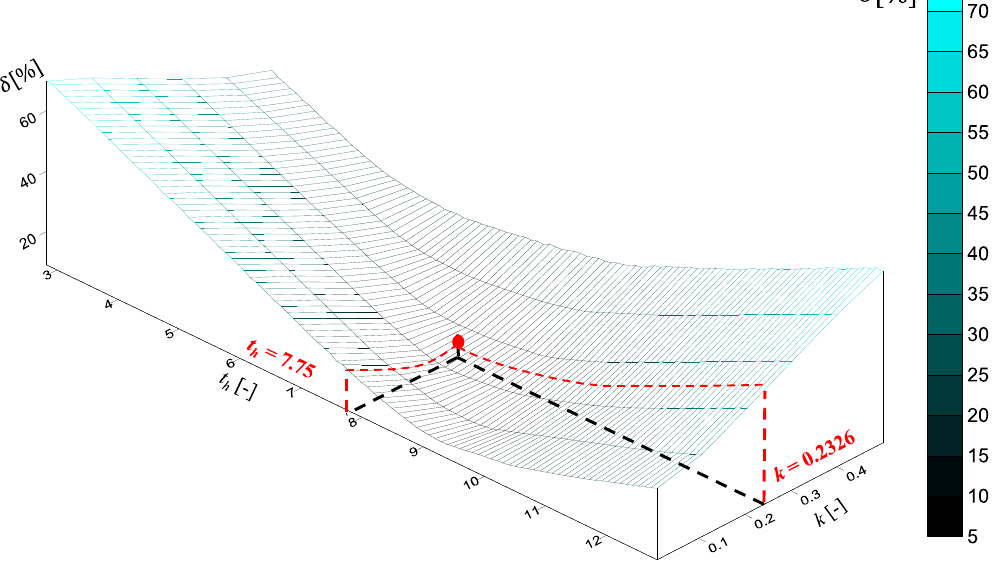
Figure 13. Mean relative error δ for simulated t h and k parameters using Begam formula (Equation (1)).